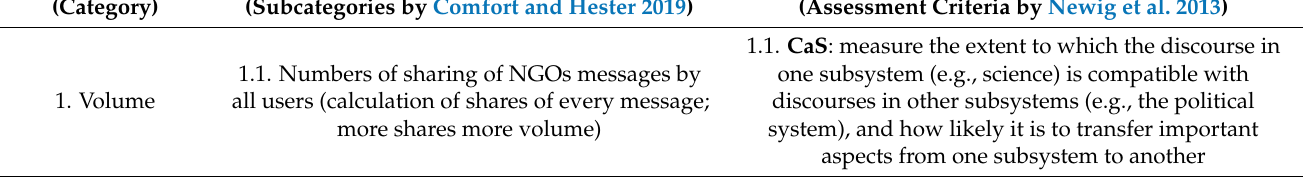
Table 2. Dimensions of measurement ENGO’s communication effectiveness. (Category) (Assessment Criteria by Newig et al.